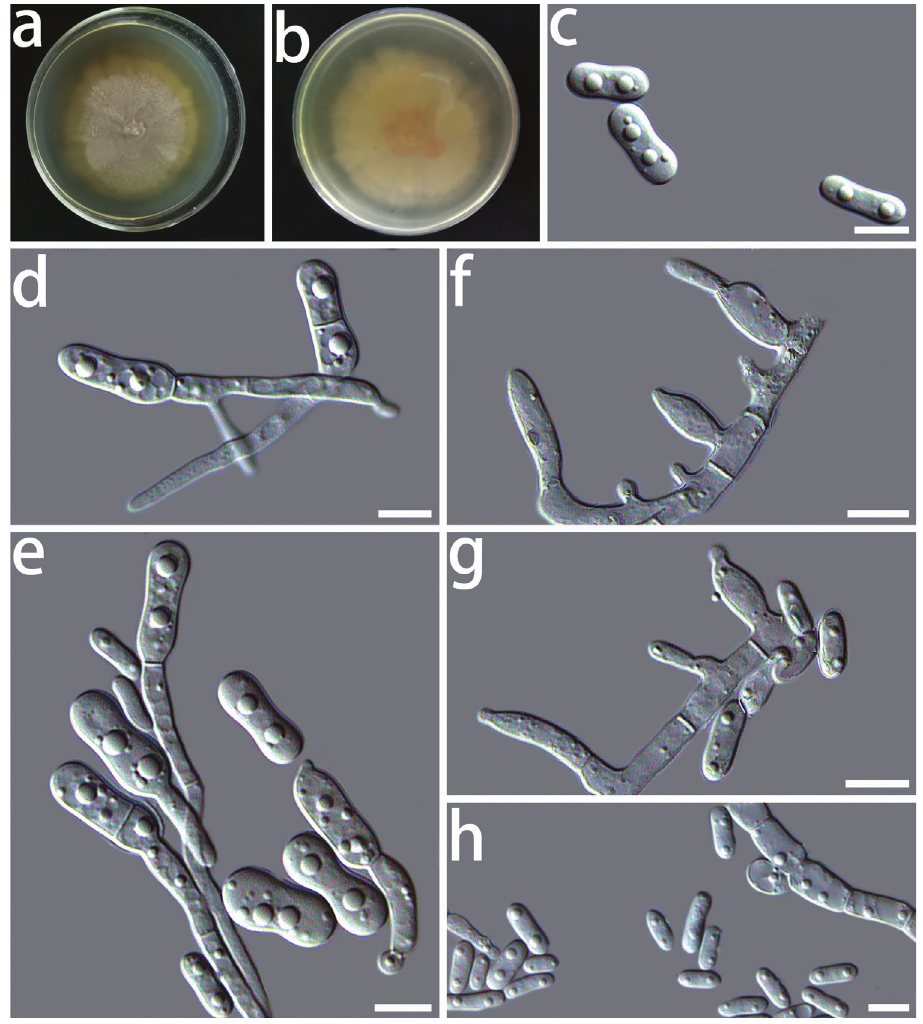
Figure 2. Morphological characters of Coniochaeta fibrosae sp. nov. (HMAS 350271) a, b cultures on PDA from the surface and reverse c swollen conidia d, e swollen conidia germinate hyphae f, g conidiog- enous cells h conidia. Scale bars: 10